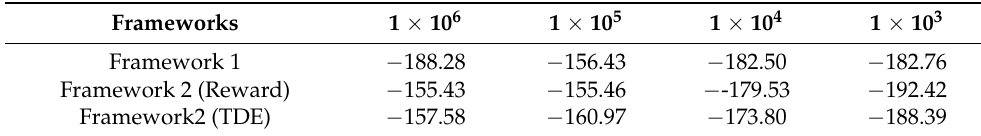
Table 6. The performance of the 9:1 sampling ratio on the frameworks across multiple buffer sizes using the F2F1 retention strategy.